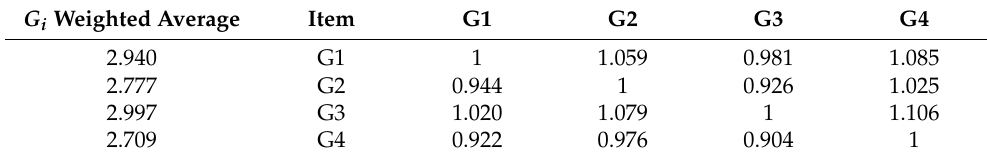
Table 6. AHP layer analysis judgment